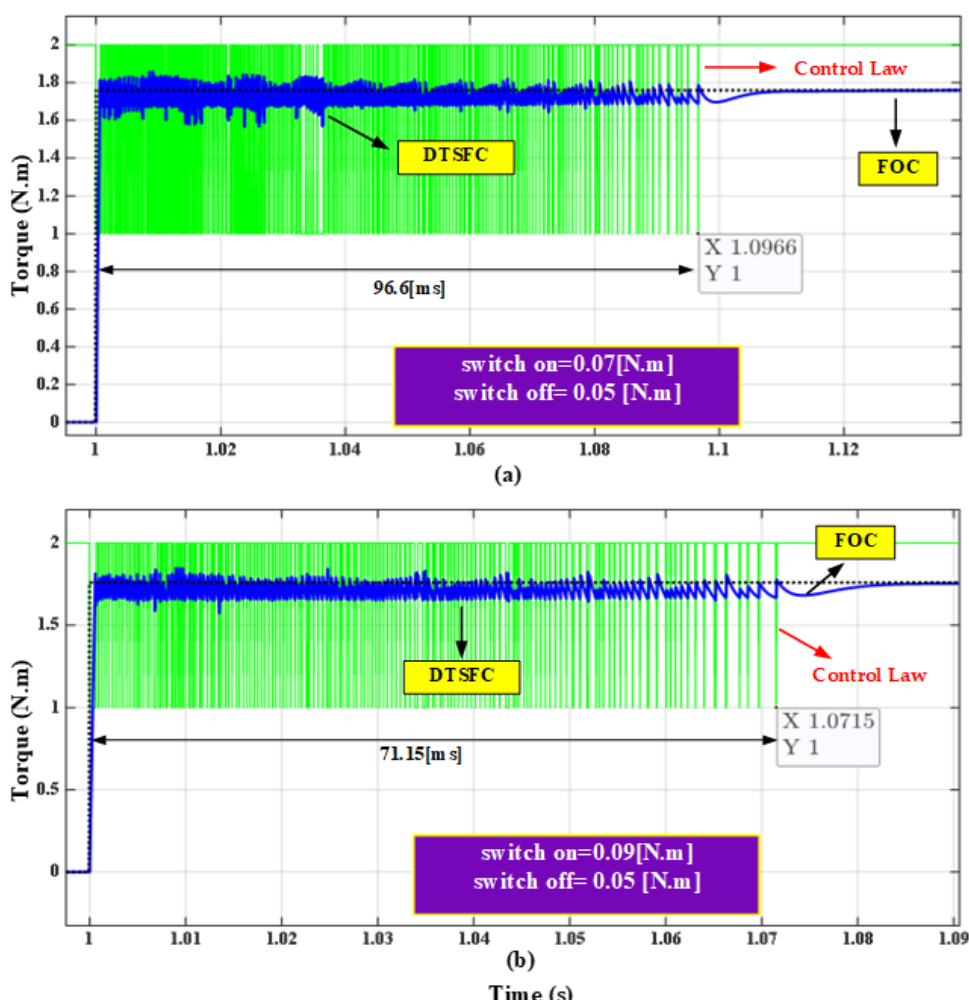
Figure 27. Torque response in the proposed combined FOC-DTC with different values of switch-on and -off.